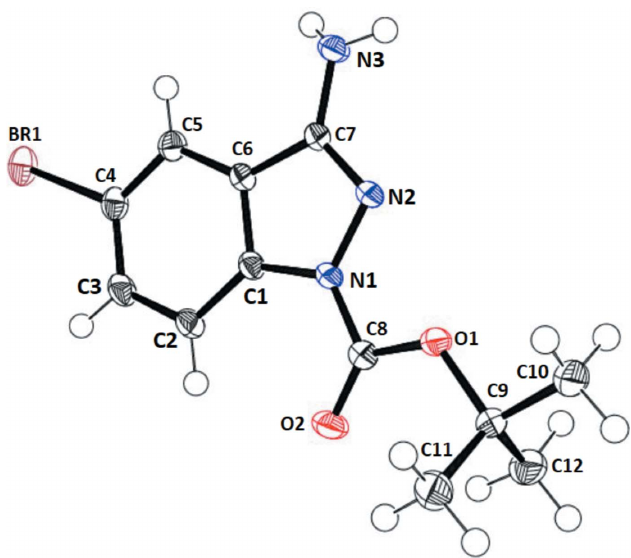
Figure 1 Aview of the structure of the title compound with displacement ellipsoids drawn at the 70% probability